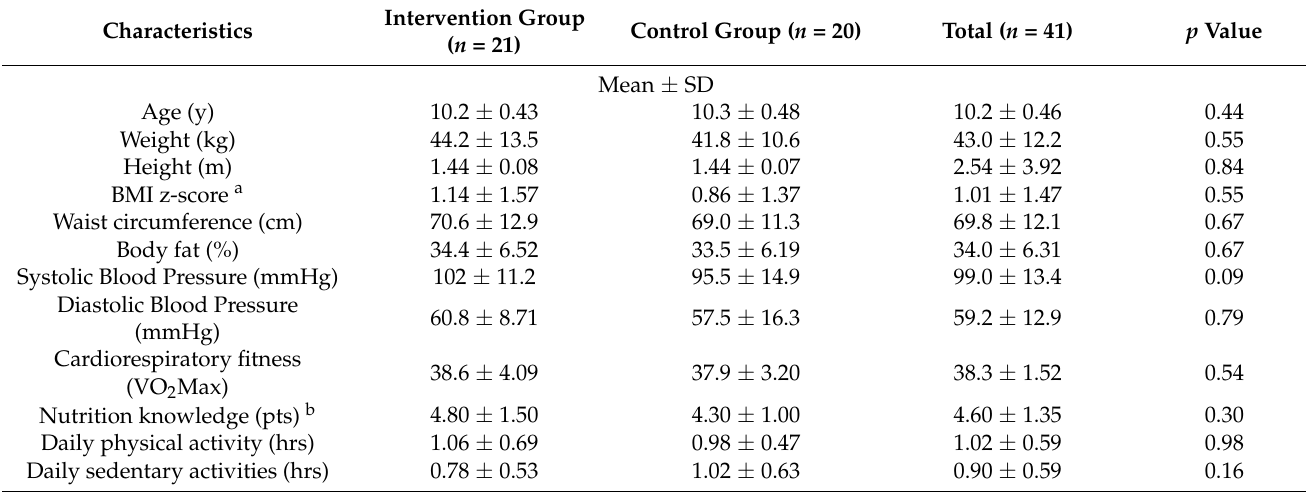
Figure 1. Participants flow chart at 9 and 23 weeks of the study. Table 2. Anthropometric, physical, lifestyle, social and family baseline characteristics of the intervention group (Planet Nutrition program) and control group